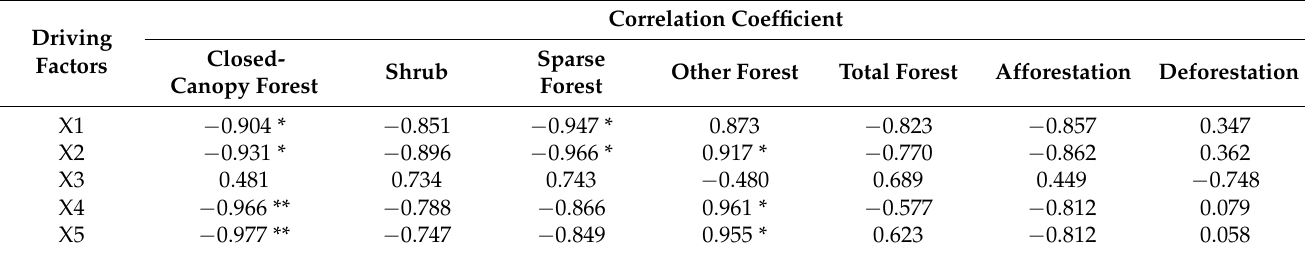
Table 5. The correlation coefficients of the driving factors of five land use